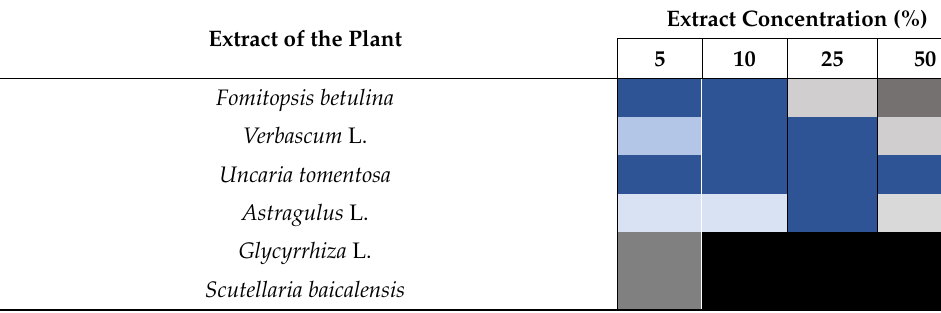
Table 2. The influence of plant extracts on S . aureus growth. Extract of the Plant Fomitopsis betulina Verbascum L. Uncaria tomentosa Astragulus L. Glycyrrhiza L.